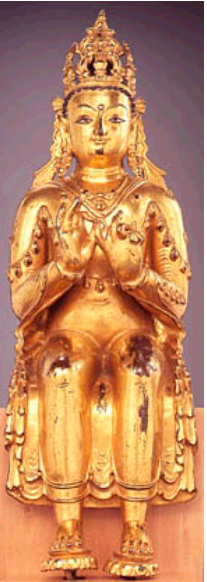
Figure 17. Buddha wearing a crown and cape performing the dharmacakra-pravartana mudr ā , eighth c. Gilgit or Kashmir. Gilt copper alloy, private collection. https://himalayanbuddhistart.files.wordpress. com/2015/08/8th-c-gilgit-shakyamuni-labellted-maitreya-gilt-bronze-photo-hughes-dubois.jpeg.